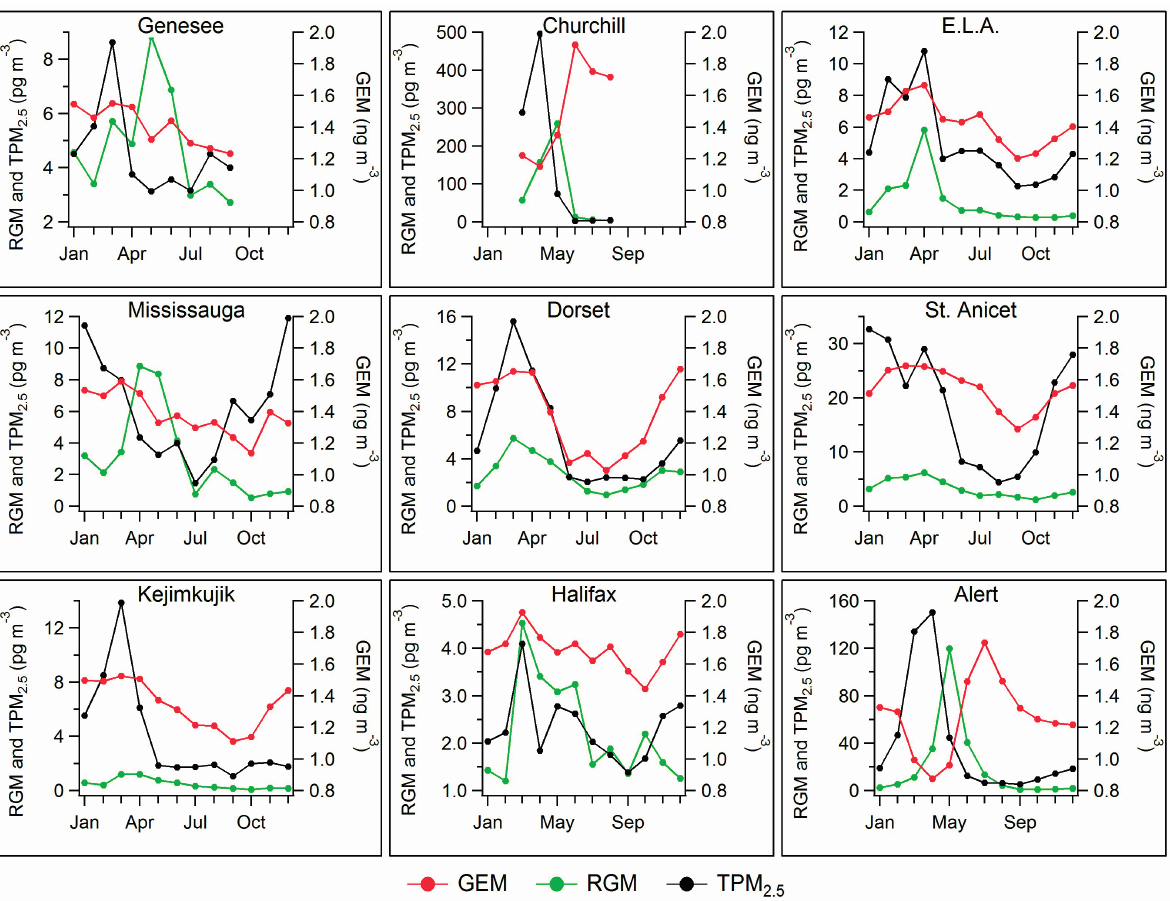
Figure 8. Seasonal cycles in speciated Hg (mean values for each month) at nine sites. Axis scales for RGM and TPM 2.5